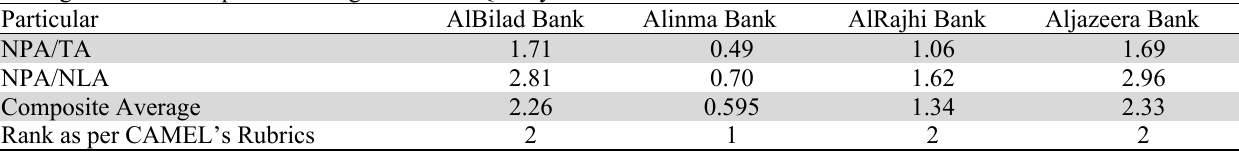
Ranking based on Composite Average of Assets Quality